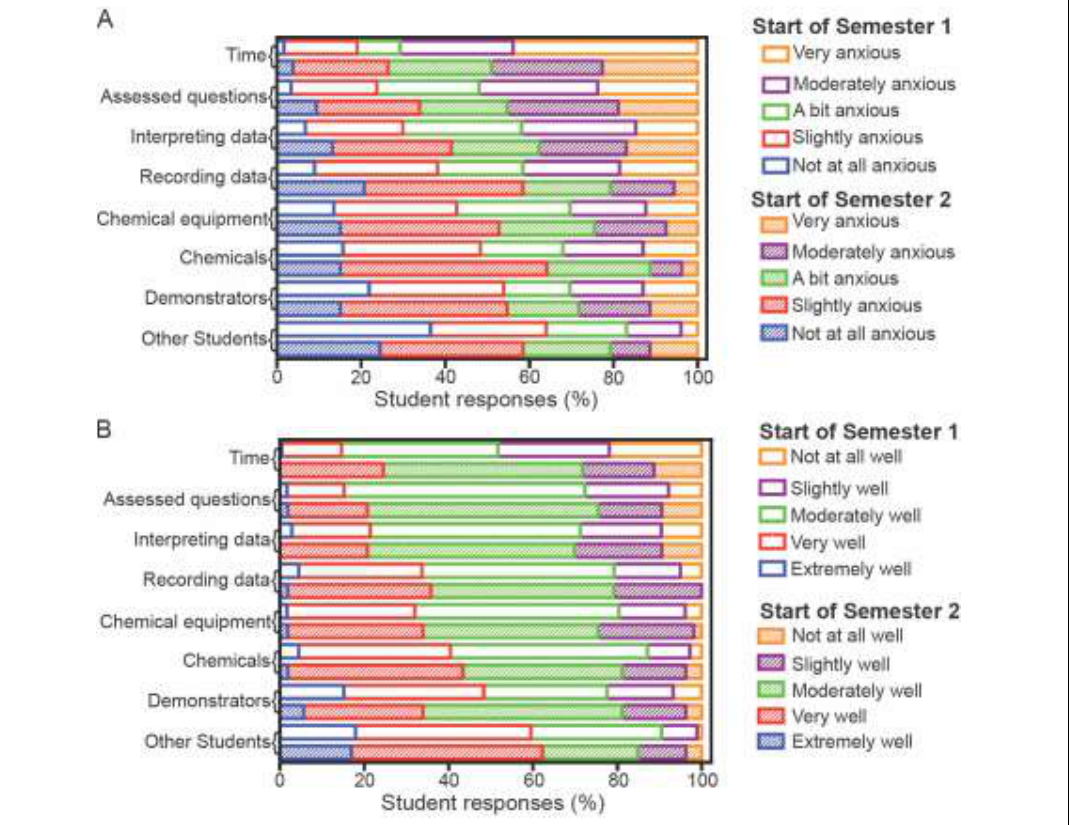
Figure 2. A) Aspects of anxiety related to the chemistry laboratory at the start of semester 1 2017 (upper bar of pair) and the start of semester 2, 2017. B) Aspects of self-efficacy related to the chemistry laboratory at the start of semester 1 (upper bar of pair) and the start of semester 2, 2017. N=173 (Start of semester 1) N = 53 (Start of semester